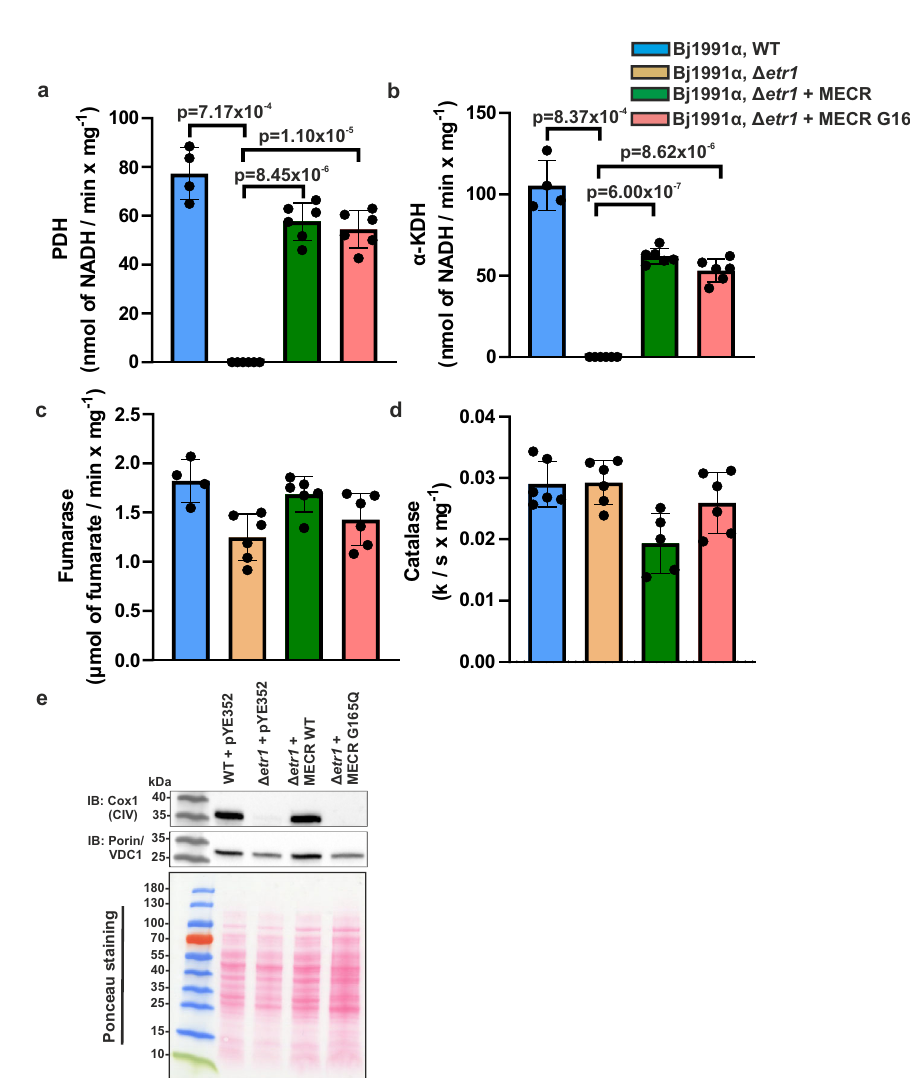
Fig. 4 | The structure of human wild-type MECR and the MECR G165Q variant. Crystal structureof the ( a ) wild-type MECR of thisstudy (PDB entry7AYB),and ( b